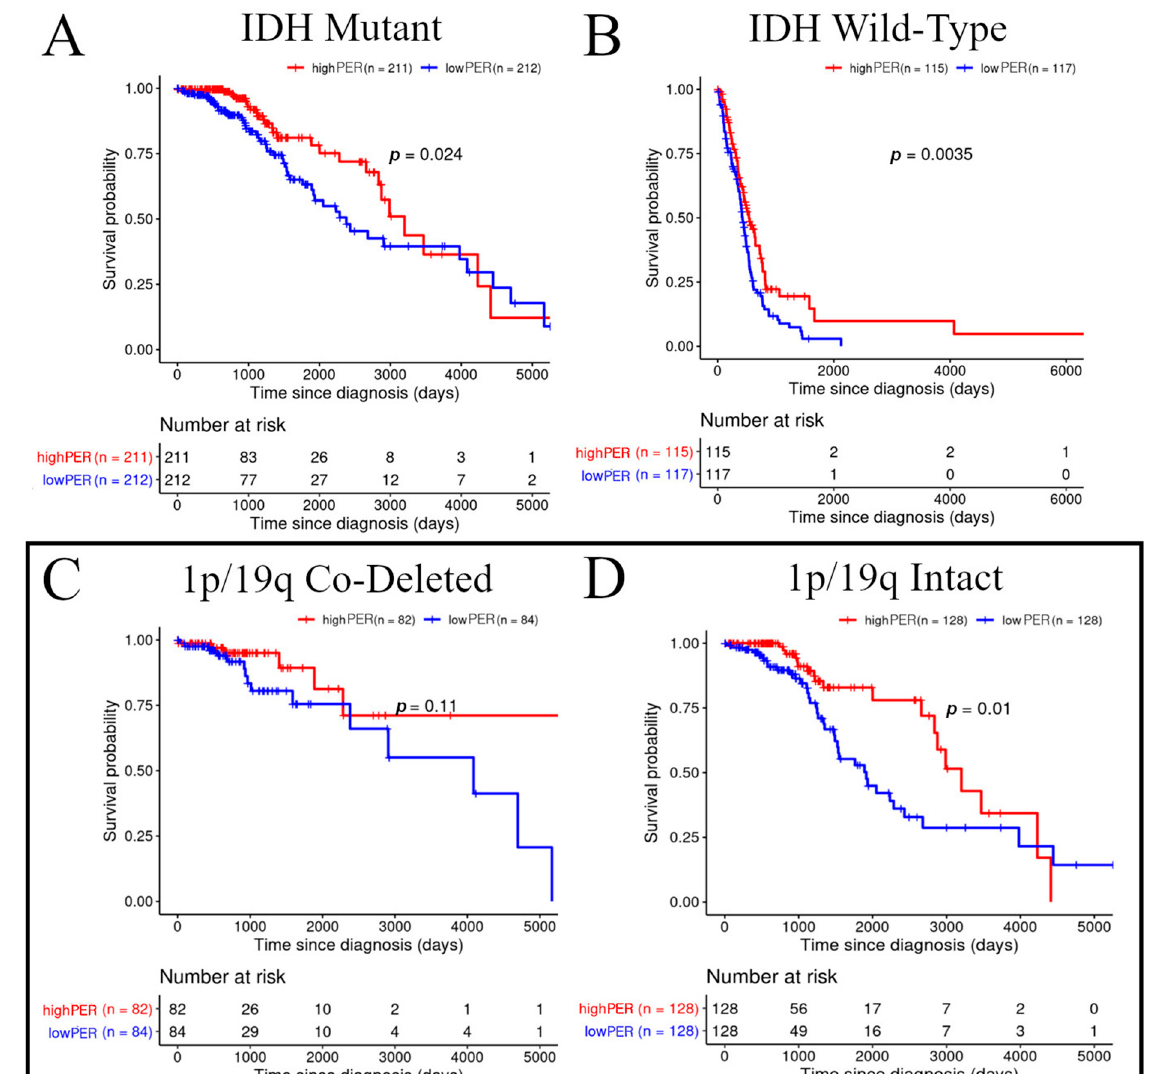
Figure 2. Clinical Relevance of PER in the TCGA dataset stratified by the IDH mutation and 1p/19q co-deletion status. ( A – D ) Kaplan–Meier curves for IDH -mutant ( A ), IDH wild-type ( B ), 1p/19q co-deleted ( C ), and 1p/19q intact ( D ) samples stratified by the median PER expression levels. The 1p/19q co-deleted and 1p/19q intact are subdivisions of all the IDH -mutant tumors. High expression (red) represents above the median of the PER expression, and low expression (blue) represents below the median of the PER expression.